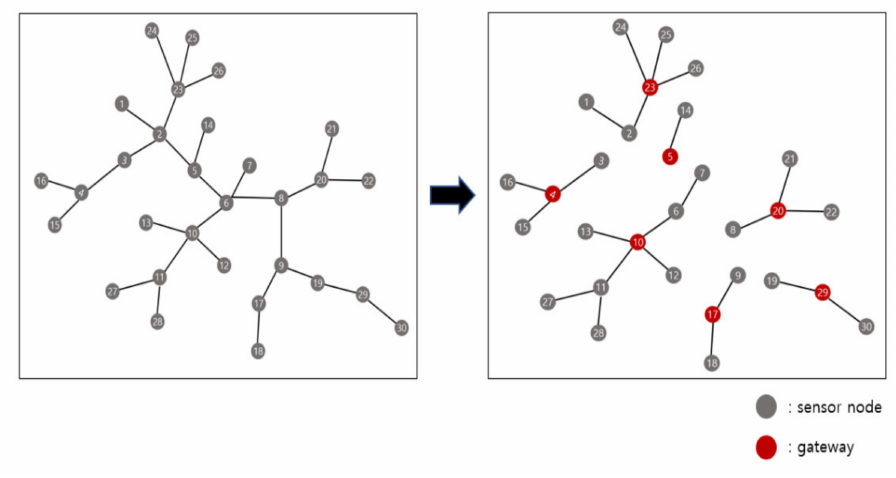
Figure 9. Example for 30 sensor nodes.